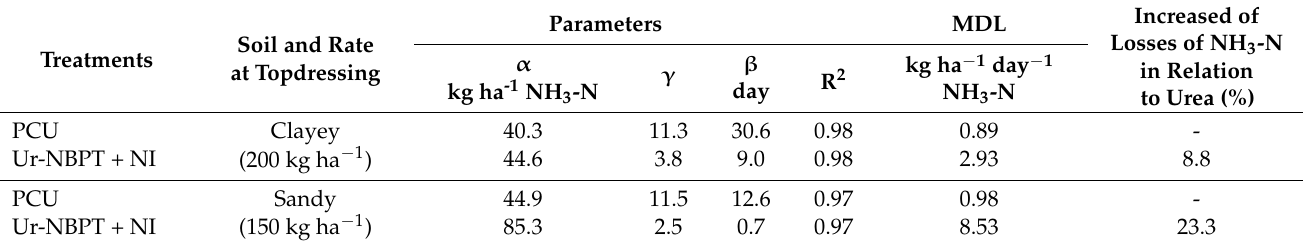
Table 3. Nonlinear regression parameters adjusted (logistic model) for NH 3 -N volatilization cumula- tive losses of the separate granules PCU and Ur-NBPT + NI and the increase of NH 3 -N emission in relation to urea for clayey and sandy